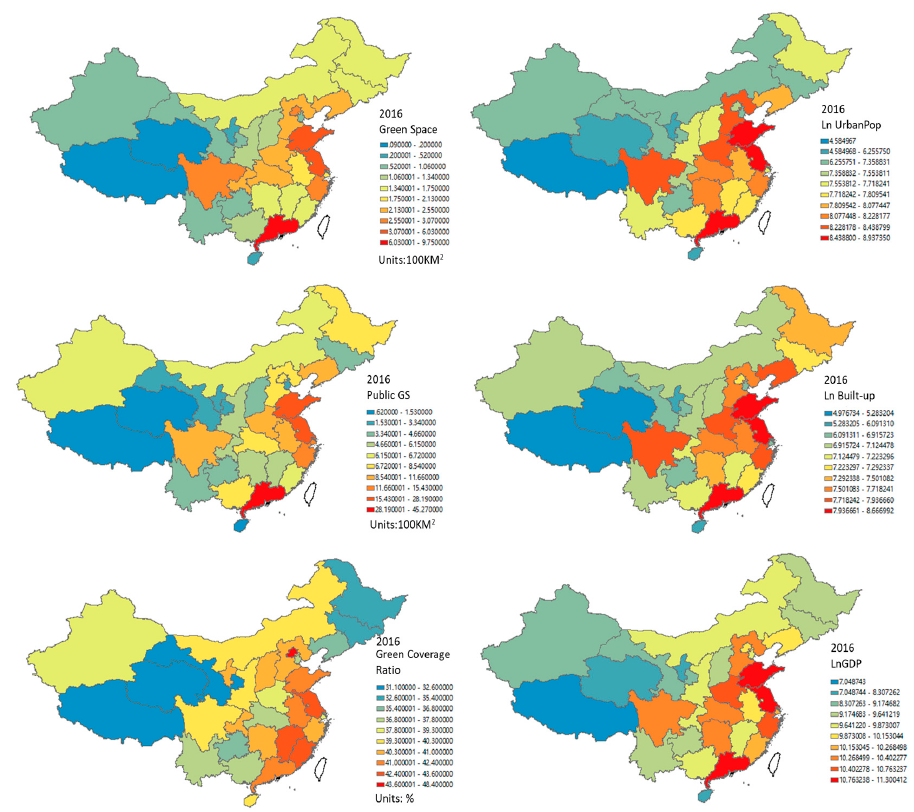
Figure 6. Geographical distribution of green space and other control variables in 2016.